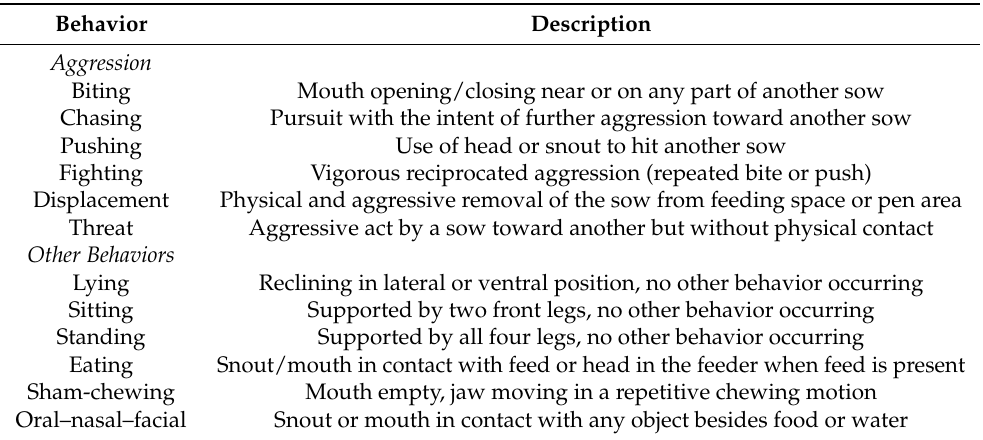
Table 2. Description of the observed and registered behaviors between 06:30 and 09:00